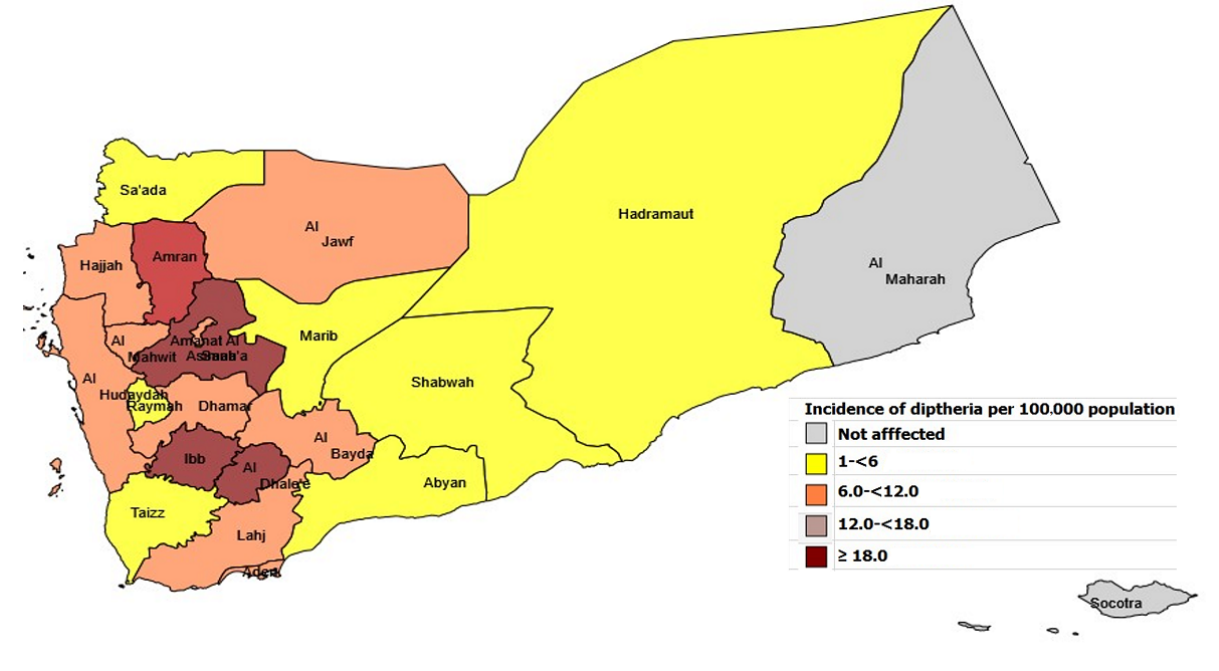
Figure 2. Incidence rate of diphtheria across governorates in